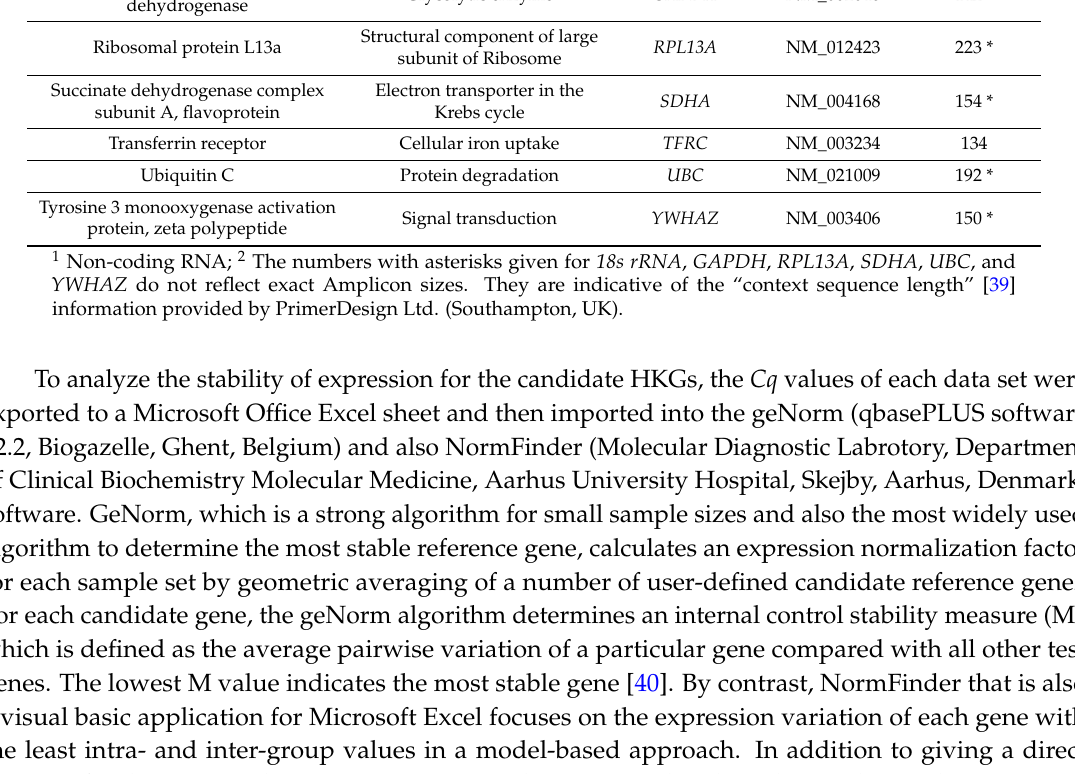
Table 3. The mean Cq values ( ± SD, n = 2–4) of samples studied in phase I.